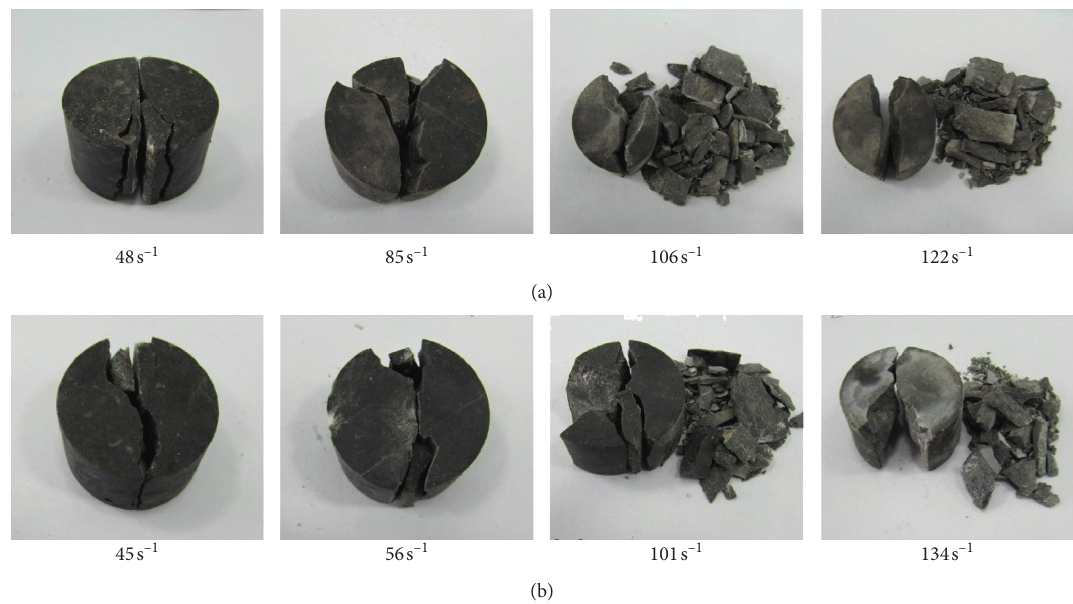
� 0MPa). (b) With static preload s